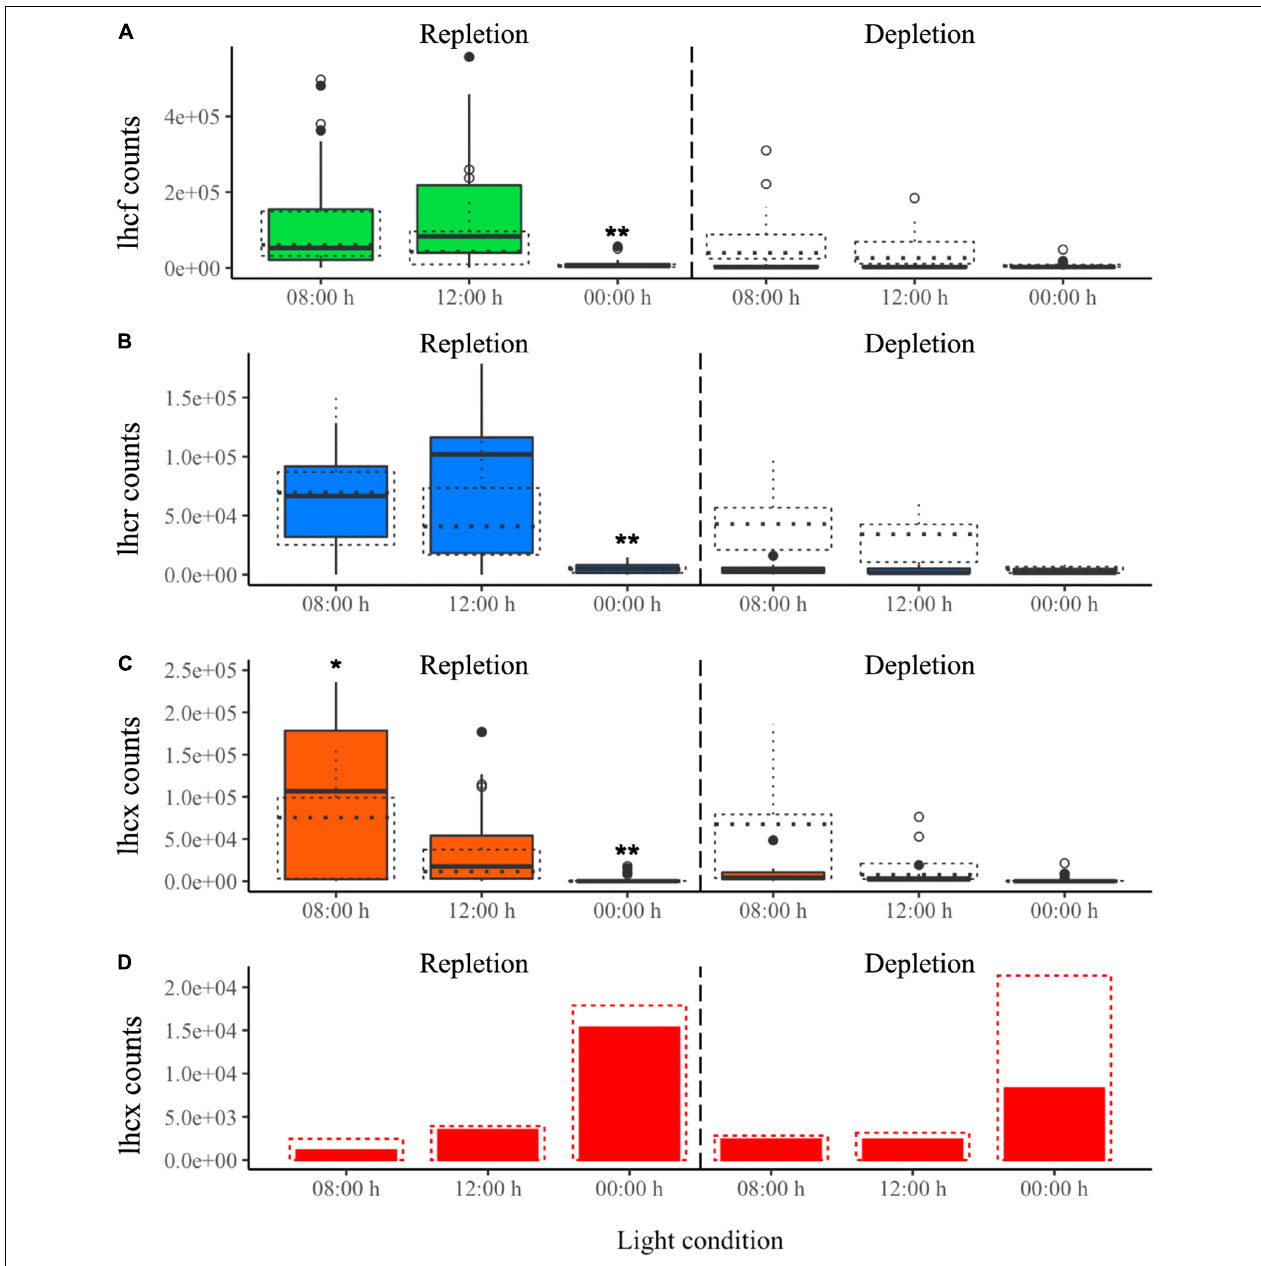
FIGURE 7 | DL experiment. Normalized transcript counts of (A) lhcf (green), (B) lhcr (blue), (C) lhcx (orange) genes and (D) lhcx2 (red) gene according to N status (repletion and depletion) and day:night cycles. ANOVA test: * p -value < 0.05, ** p -value < 0.01. The experiment was realized in duplicate and represented by solid (replicate 1) and dotted lines (replicate 2). Vertical black dashed line marks the transition between the repletion and depletion phases in